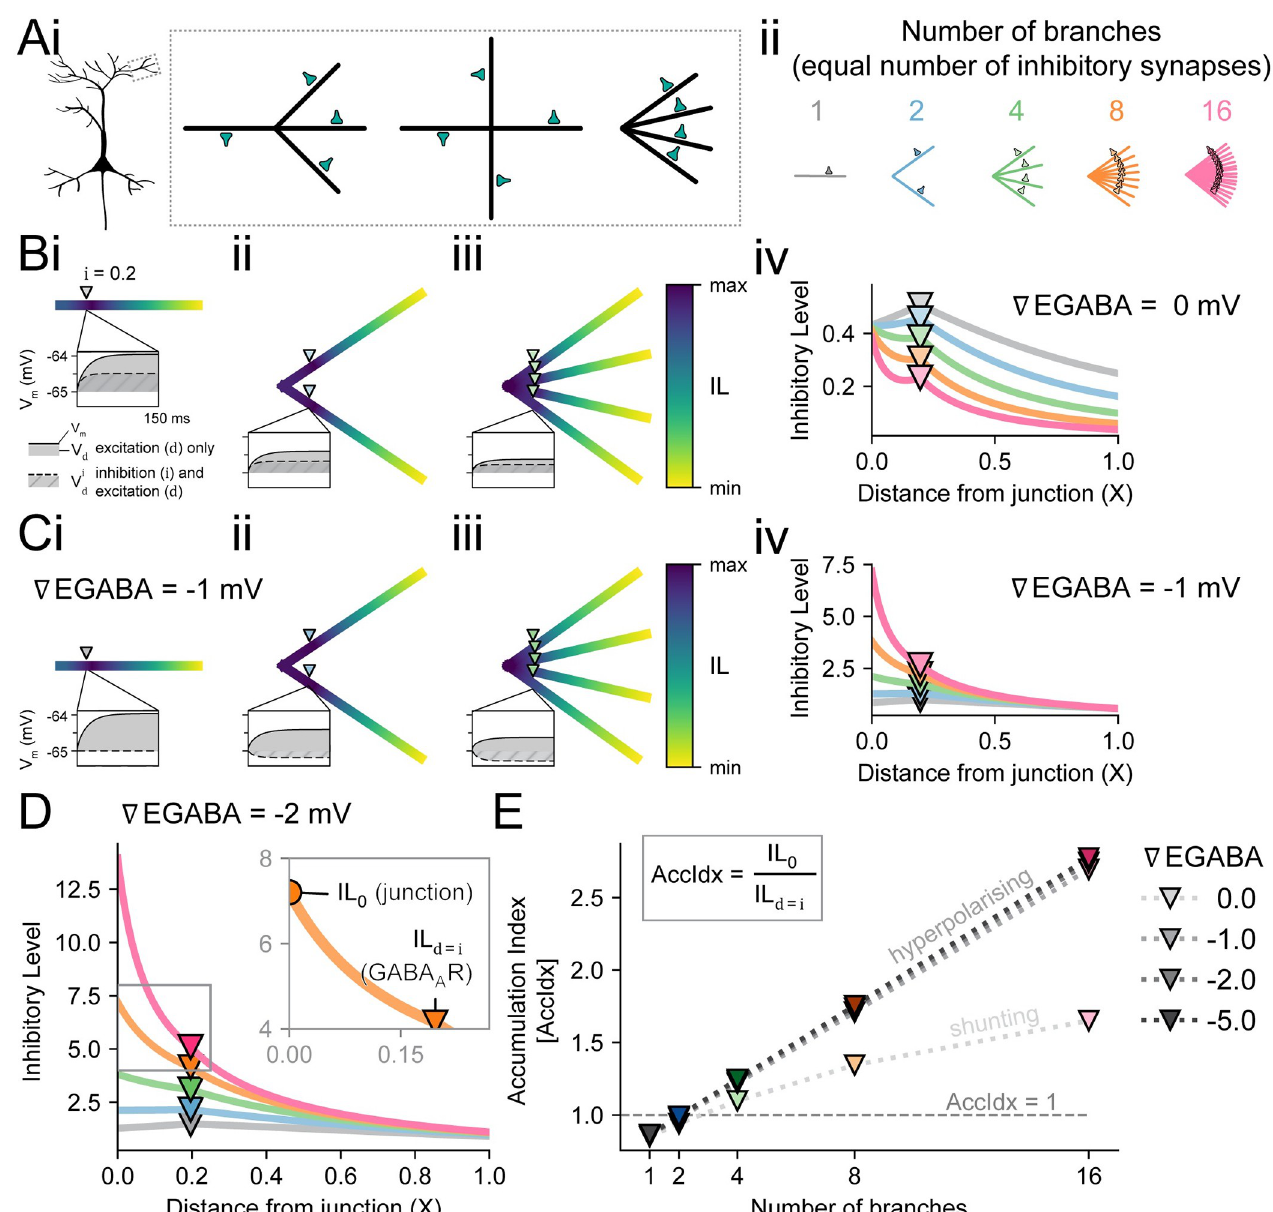
Fig 2. Dendritic inhibition has a cumulative effect at a dendritic junction. (A) A 4 branch dendrite morphology can be thought of as 3 branches joining into an identical other branch, all branches coming from different directions, or as 4 branches joining together at a single point. These equivalent situations are pictured in ‘Ai’, with the rightmost depiction used throughout. The morphologies for different number of branches with equal number of inhibitory synapses are depcited in ‘Aii’. (B) The point of maximum Inhibitory Level (IL) for shunting inhibitory synapses at 0.2 X (downward triangle) shifts to the junction as the number of dendritic branches increases, as shown by the heatmaps in ‘Bi-iii’ and summarised in ‘Biv’. The “max” and “min” in the IL heatmaps are the maximum and minimum IL values for each morphology (in contrast to a shared heatmap across all morphologies). (C) When EGABA is set hyperpolarised to the resting membrane potential ( r EGABA < 0), the inhibitory synapse no longer only shunts (pure conductance-driven effect) but instead also has an additional inhibitory postsynaptic potential (IPSP) contribution. ‘Ci-iii’ shows the IL heatmaps for 1 (Ci), 2 (Cii), and 4 (Ciii) equal dendritic branches for a hyperpolarising inhibitory synapse at -1 mV below resting V m . ‘Civ’ shows the corresponding IL values, along with morphologies with 8 or 16 branches. (D) IL for an inhibitory synapse with an r EGABA of -2 mV. (D, inset) IL for 8 branches between the junction at 0.0 X and the inhibitory synapse at i (X = 0.2 in this figure). The ratio between the IL at the junction (IL 0 ) and the IL at i (IL d = i ) is the Accumulation Index (AccIdx) and reflects the cumulative effect of inhibitory synapses on multiple dendrites at a junction. (E) Accumulation Index as a function of the number of branches and the relative reversal potential ( r EGABA) of the inhibitory synapse (shade of downward